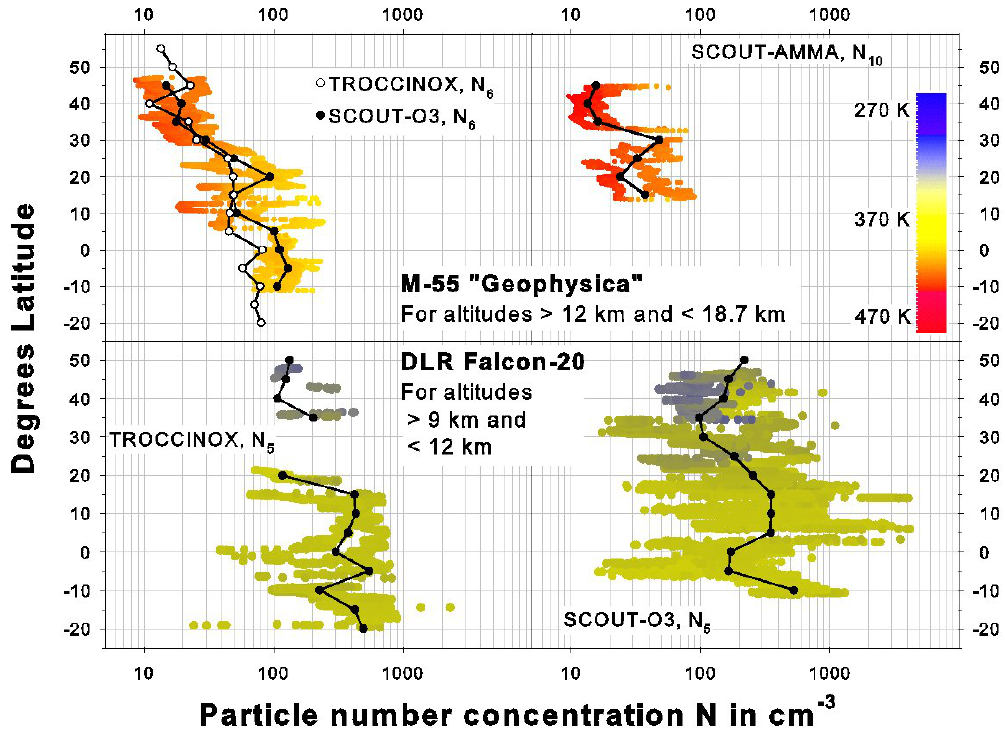
Fig. 2. Number densities and variability of submicron particles N 5 , N 6 , N 10 (i.e. with size diameters larger than 5nm, 6nm, 10nm, and smaller than ≈ 1µm) as function of geographical latitude and altitude (in potential temperature) from the transfer flights. In all panels the filled dots and open circles associated with the black lines represent medians of five degree latitude bins and the coloured data points are 15s flight time averages. Upper left panel: The line with the open circles includes flights between Germany and Brazil (20 to 27 January 2005; return: 24 February until 2 March 2005). The filled symbols refer to the transfer to Australia (4 until 12 November 2005) and back (9 until 17 December 2005). Upper right panel: Concentrations ( N 10 ) of the transfers from Europe to Burkina Faso (31 July and 1 August 2006) and back (16 and 17 August 2006). Lower panels: Latitudinal profiles of N 5 in the 9 to 12km altitude band between Europe and Brazil (left) and between Europe and Australia